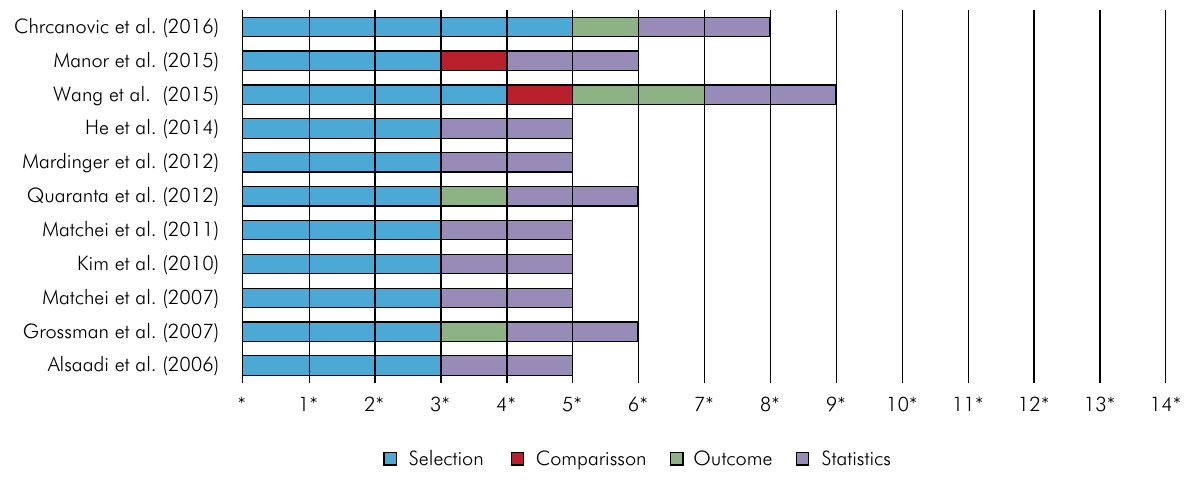
Figure 3. Methodological quality of included studies. Study quality was categorized as high (11 to 14 total star points), moderate (8 to 10 stars), or low (0 to 7 stars), according to a modified Newcastle-Ottawa Scales (NOS).